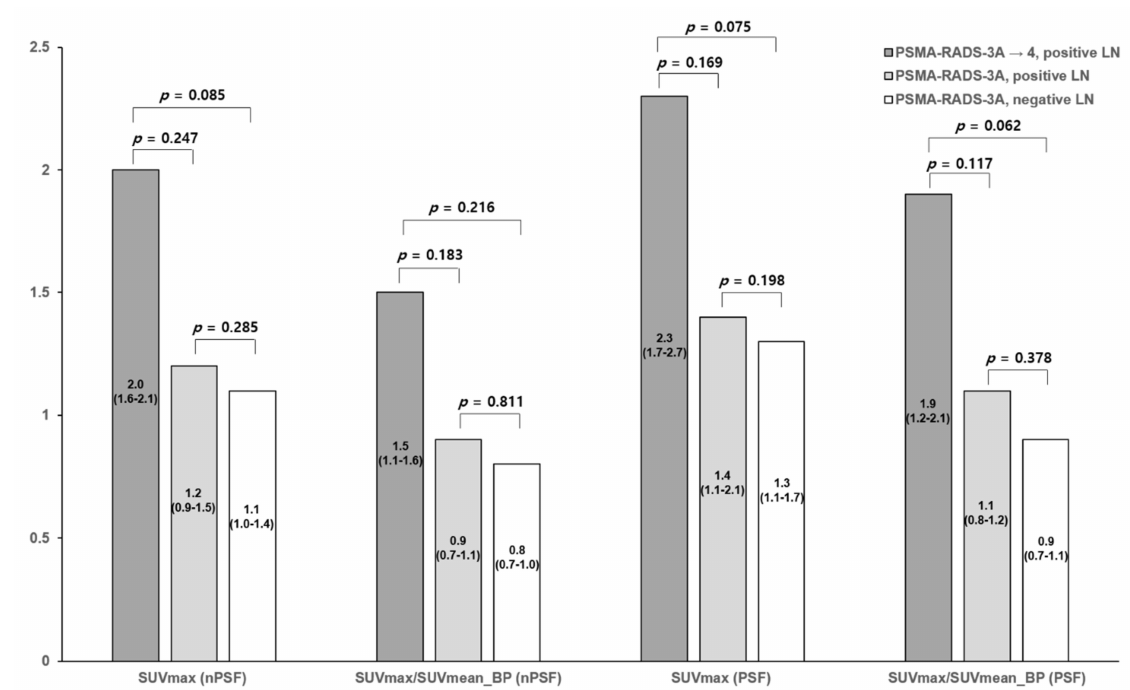
Figure 2. Bar graph representation of medians and interquartile ranges for the SUV max -lesion and SUV max -lesion/SUV mean - blood-pool metrics of the PSMA-RADS-3A lesions included in this study. In each bar of the graph, the top number is the median and the interquartile ranges are listed below. Note the trends towards higher SUVs of the lesions that were re-categorized as PSMA-RADS-4 (dark grey), although none of these relationships reached statistical significance (i.e., all p > 0.05). SUV = standardized uptake value; nPSF = non-point-spread function; BP = blood-pool; PSF = point-spread function; LN = lymph node.